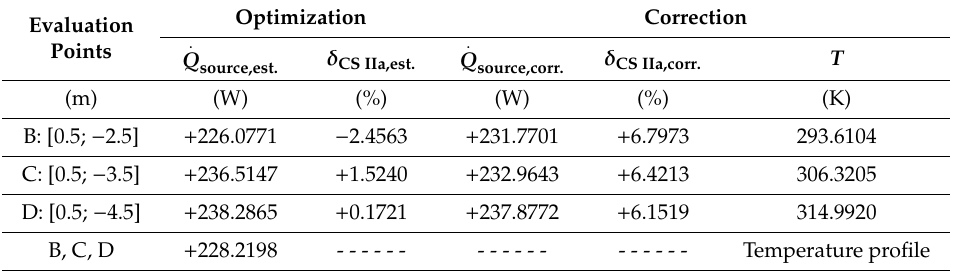
Table 8. Case study IIb: 90% of reference values of the negative heat sources the nominal values of the heat sources